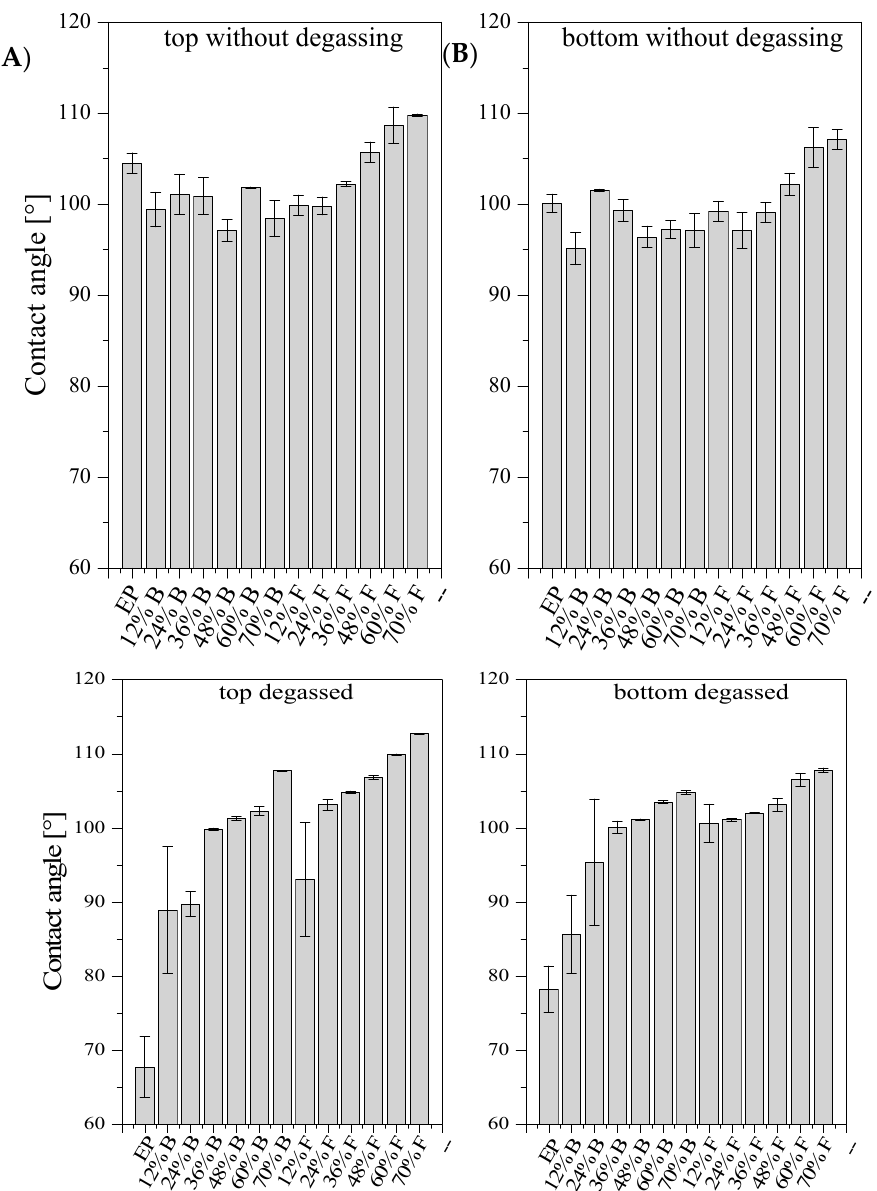
Figure 16. Contact angle bottom ( A ) and top ( B ) for degassed and non-degassed composites containing base (“B”) diatoms and fractionated (“F”) diatoms.